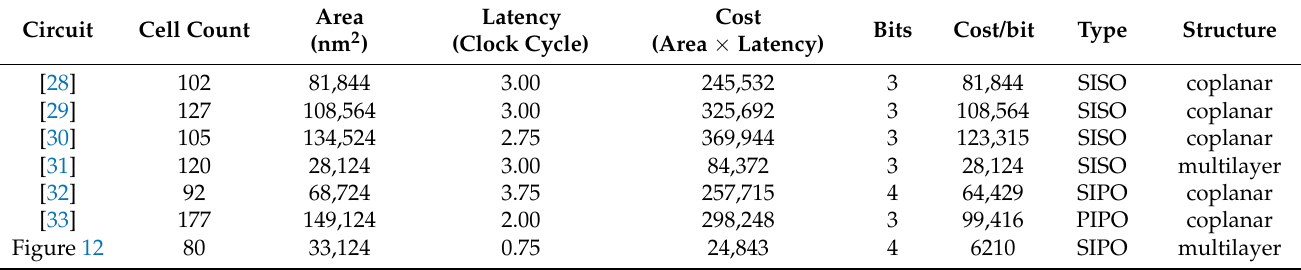
Table 7. Performance comparison of QCA SR.